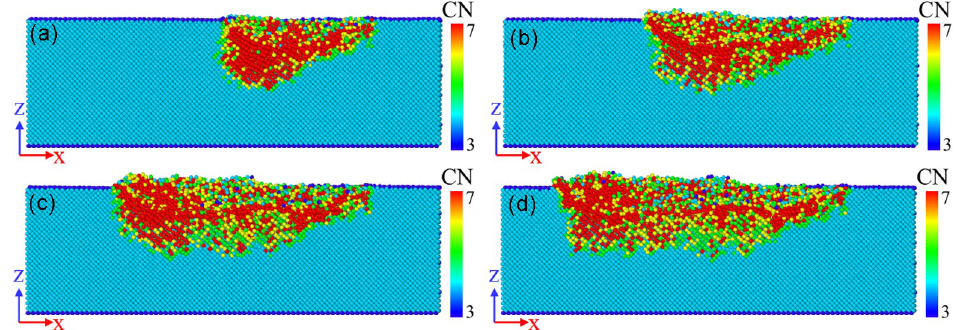
Figure 4. Cross-sectional view of deformation behaviors of GaAs(001) in scratching at sliding distances of ( a ) 2nm, ( b ) 5nm, ( c ) 8 nm, and ( d )10 nm. The scratching depth is 1.5 nm. The atoms are colored by coordination number (CN).